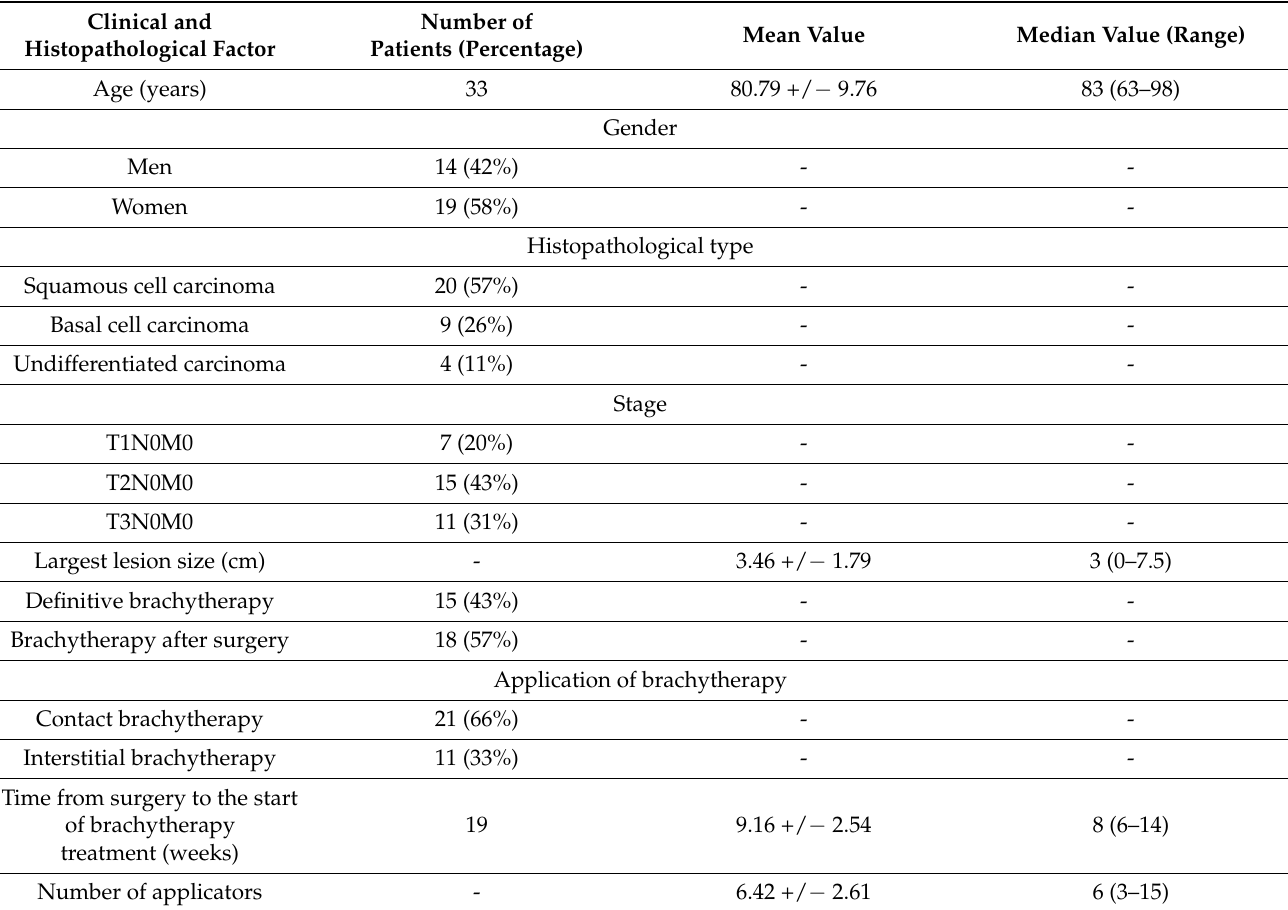
Table 1. Clinical and histopathological characteristics of patients undergoing